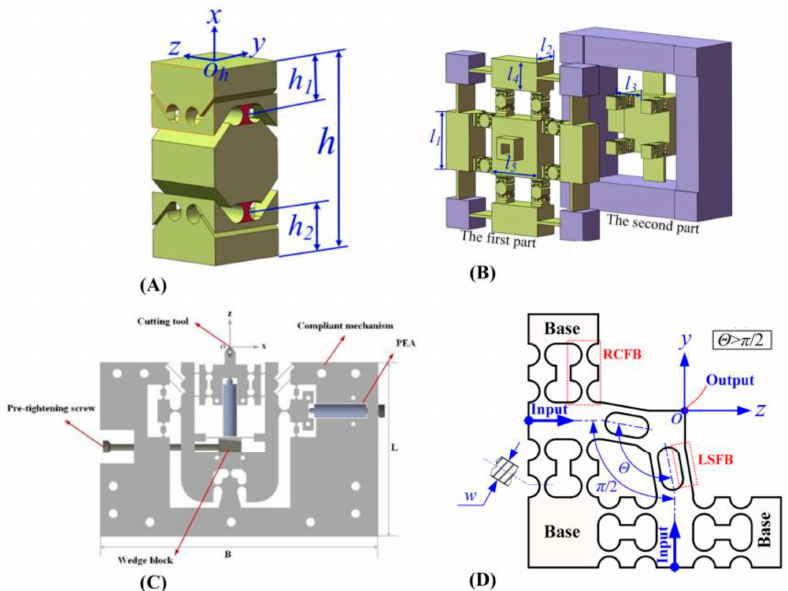
Figure 19. Examples of CM-based FTSs with decoupled motions. ( A ) Dual-axis notched flexure [85]; ( B ) FTS with dual-axis notched flexures for both x (first part) and z (second part) direction decou- pling [85]; ( C ) FTS with symmetrically laid out blade hinges [128]; ( D ) A non-orthogonal CM with blade hinges for motion decoupling